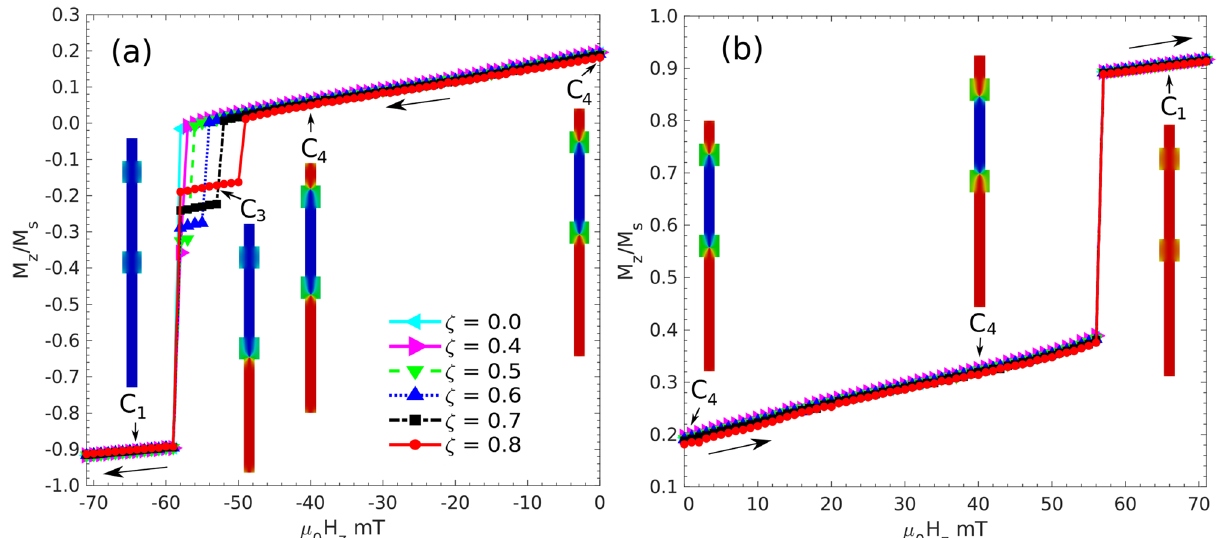
Figure 4. Magnetization curves for an initial C 4 configuration and a varying external constant and uniform magnetic field applied in a negative (a) and positive (b) direction along the z-axis. In this representative example ℓ 2 = 300 nm and different ζ values are considered as given in the inset. Illustration of the magnetization (using the same color code as before) in the system are given at representative field values for case ζ = 0.8